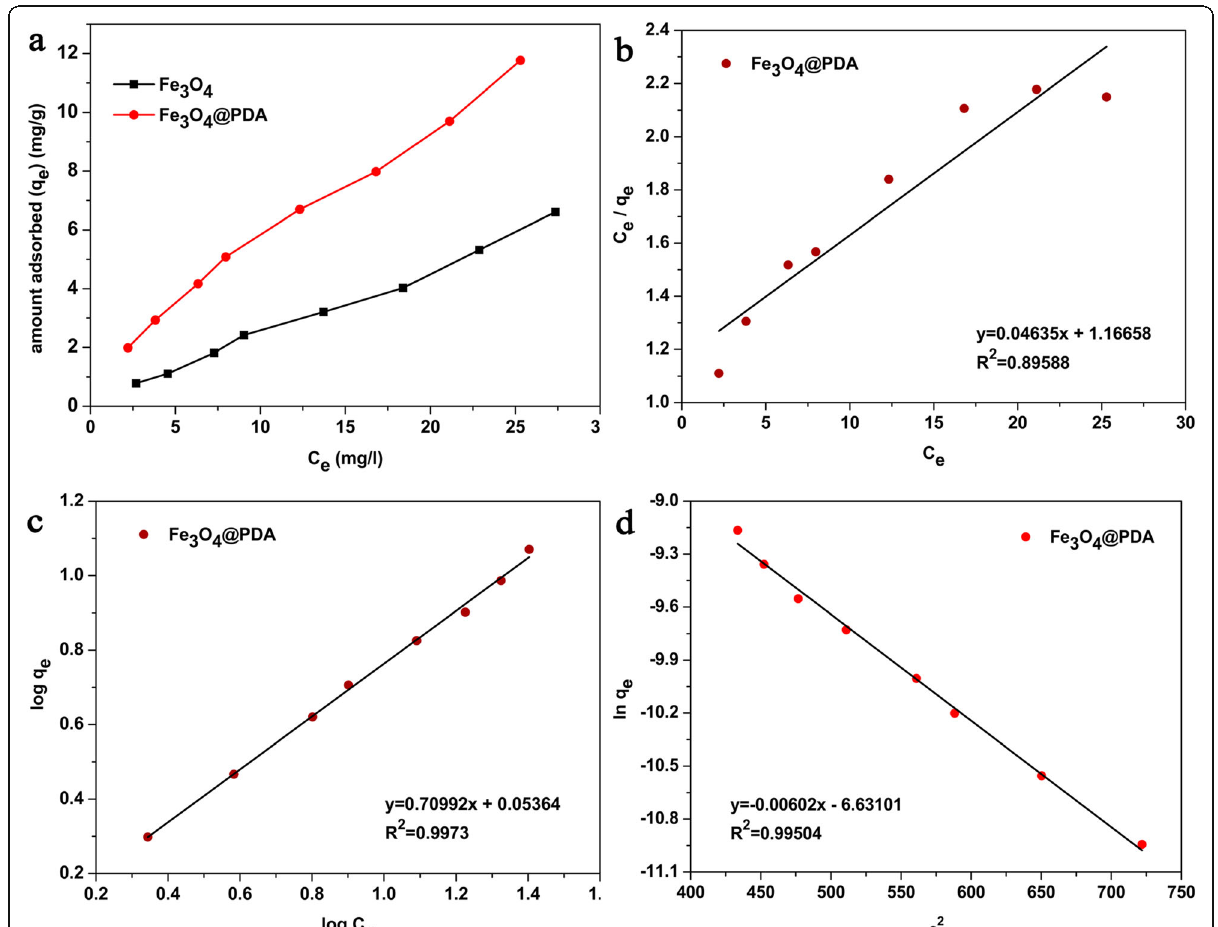
Fig. 5 a Effect of the Cd 2+ concentration on the adsorption capacity, b Langmuir isotherm, c Freundlich isotherm, and d D-R isotherm for the adsorption of Cd 2+ by Fe 3 O 4